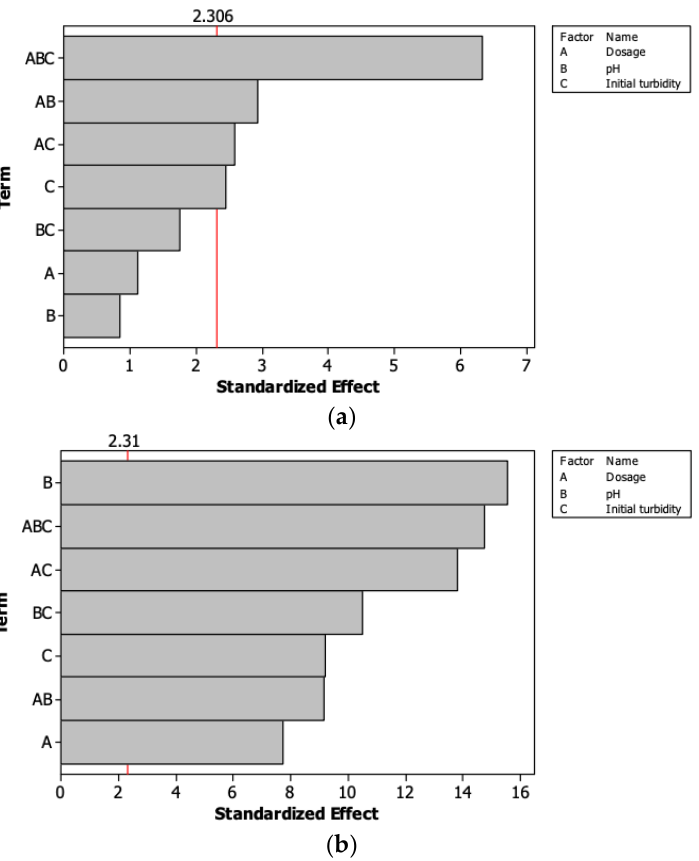
Figure 3. Pareto effects that correspond to regression performed for ( a ) turbidity removal and ( b ) coagulation activity from the synthetic kaolin water, p -value = 0.05.